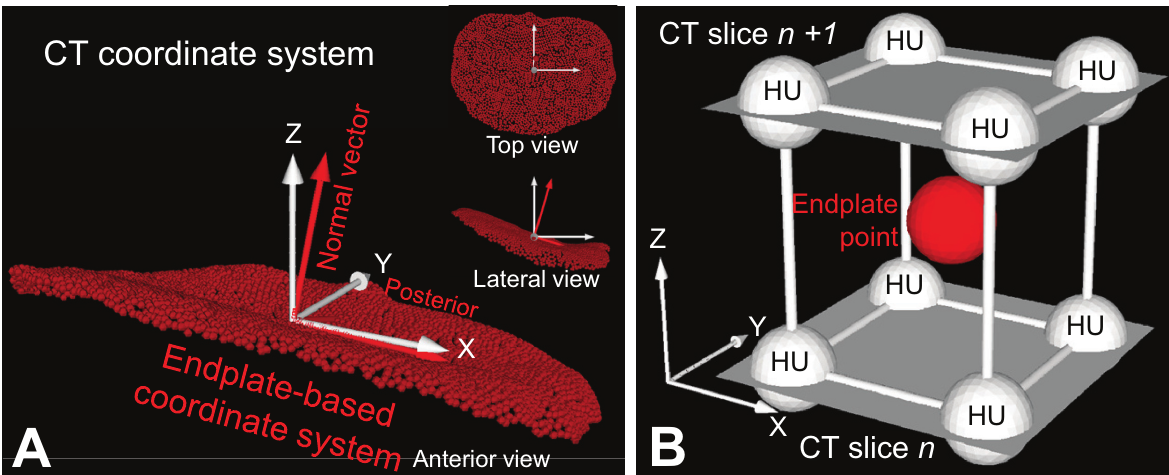
Fig 1. Endplate point-cloud surface model and determination of attenuation in Hounsfield Units (HU) at individual point of the model. A: point-cloud model ( red points ), endplate-based coordinate system ( red arrows ) and CT coordinate system ( white arrows ). B: 3D spatial relationship between an arbitrary point of the endplate point-cloud model ( red point ) and 8 adjacent points in the 2 adjacent CT images (white points). White arrows; CT coordinate system.